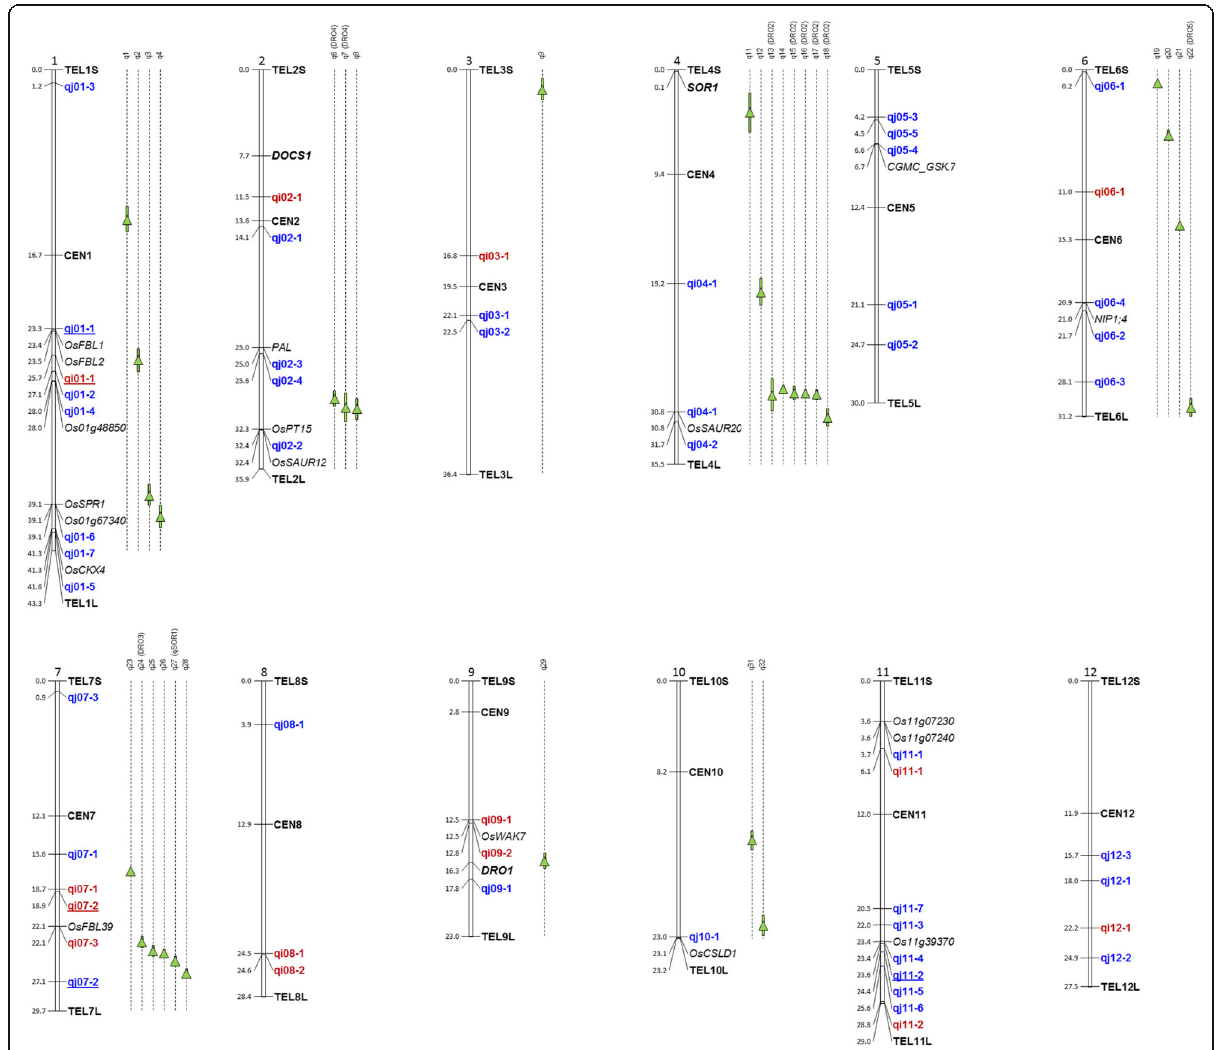
Fig. 2 Position of genes and QTLs for root cone angle or related traitsIn black, genes from the literature listed in Additional file 1: Table S1 and candidate genes from Table 9; in green QTLs from the literature listed in Additional file 1: Table S1; in red (indica panel) and blue (japonica panel), QTLs detected in this study (from Tables 3 to 8); QTLs detected both in GBS and HDRA panels are Elshire et al. (2011) or to the re-sequencing of the rice genome and the discovery of millions of single- nucleotide polymorphisms (SNPs) (Alexandrov et al. 2015). GWAS allows for a precise localization of QTLs due to the rapid decay of linkage disequilibrium (LD) in the association panels. However, rice incurs a high risk of false-positive tests during GWAS because of the bipo- lar genetic structure of the species. This structural effect can be corrected by using panels specific to each subspe- cies and by using models that consider subpopulation structure and kinship. Several large panels of rice var- ieties genotyped with high marker density have been de- veloped for GWAS (e.g., Huang et al. (2010), Zhao et al. (2011), McCouch et al. (2016)). A panel called Orytage composed of 170 japonica rice accessions and 204 indica